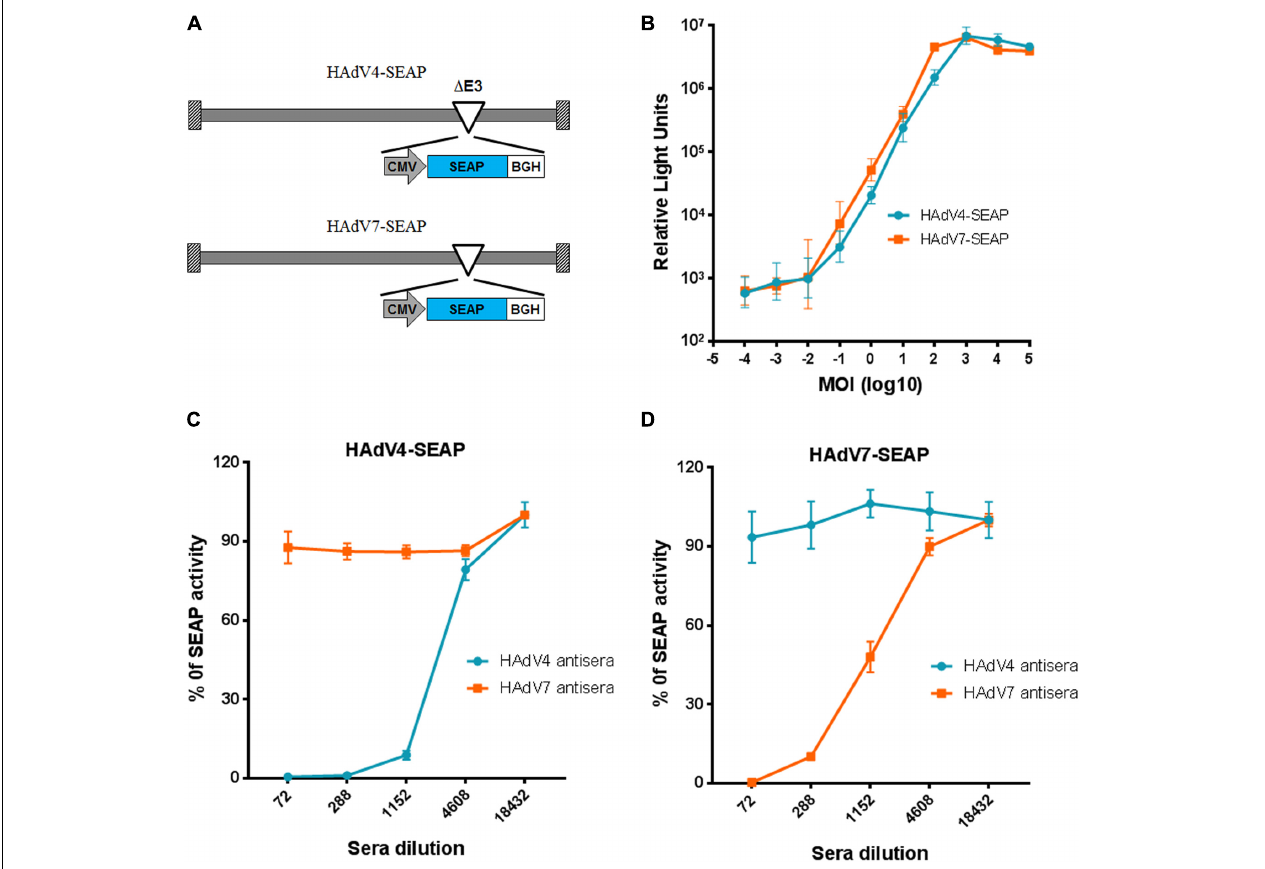
FIGURE 1 | Establishment of neutralization assays based on HAdV4-SEAP and HAdV7-SEAP. (A) The schematic diagram of HAdV4-SEAP and HAdV7-SEAP. (B) Detection of SEAP activity in the culture supernatants of HAdV4-SEAP or HAdV7-SEAP infected cells. HEK293 cells were infected with HAdV4-SEAP or HAdV7-SEAP at serially increasing doses. At 24 h after infection, the culture supernatants were collected and the SEAP activity was assessed. Shown are the representative data of three independent experiments. (C,D) Neutralization curves of HAdV4 antisera and HAdV7 antisera to HAdV4-SEAP (C) and HAdV7-SEAP (D) . Mouse antisera were serially diluted and incubated with HAdV4-SEAP (C) or HAdV7-SEAP (D) . After incubation for 1 h, the mixtures were added to HEK293 cells. One day later, the SEAP activity in the culture supernatants were examined. Cells infected with HAdV4-SEAP or HAdV7-SEAP in the absence of antisera were used as viral infection alone controls. Shown are the percentages of SEAP activity in the presence of antisera versus viral infection alone. The data were representative of two independent experiments. Error bars stand for mean ± standard deviation